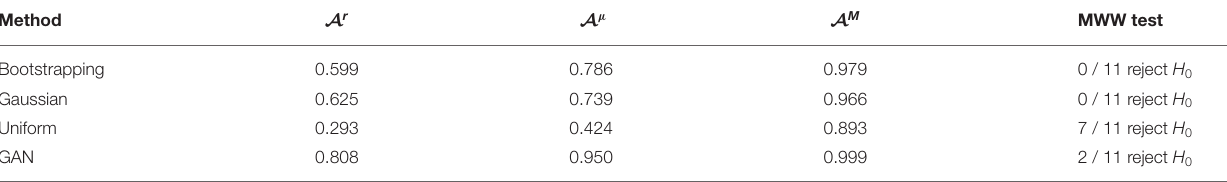
TABLE 3 | Results of the generation of synthetic aorta cohorts with different sampling methods.